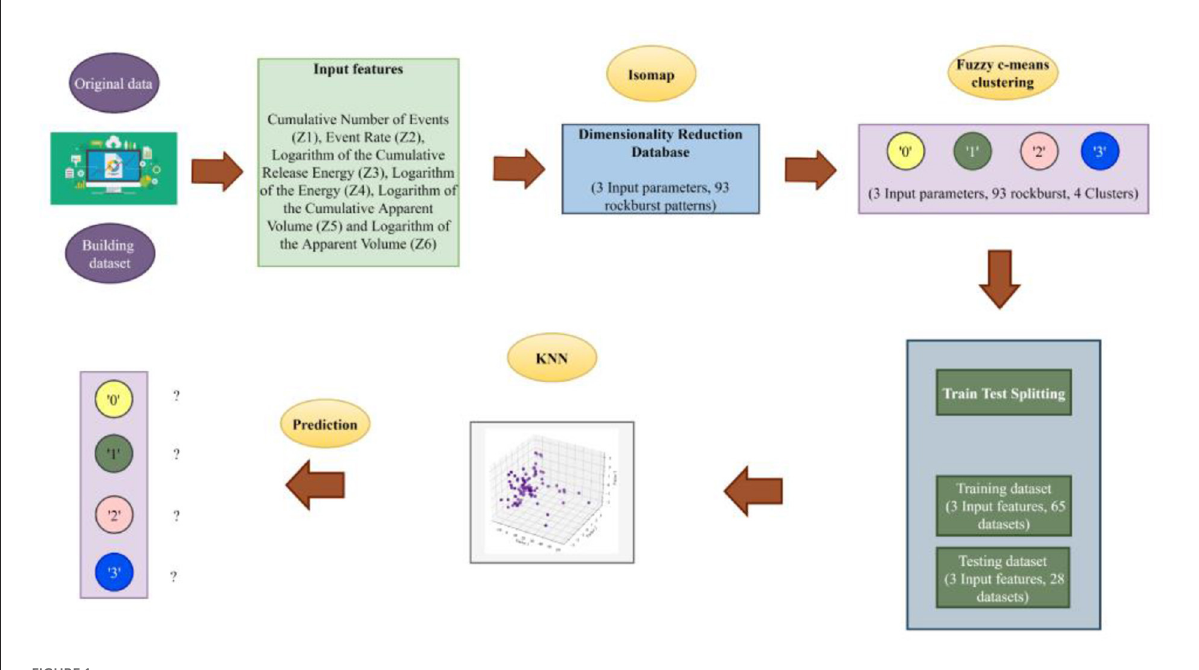
FIGURE1 Flowchart of the proposed study.